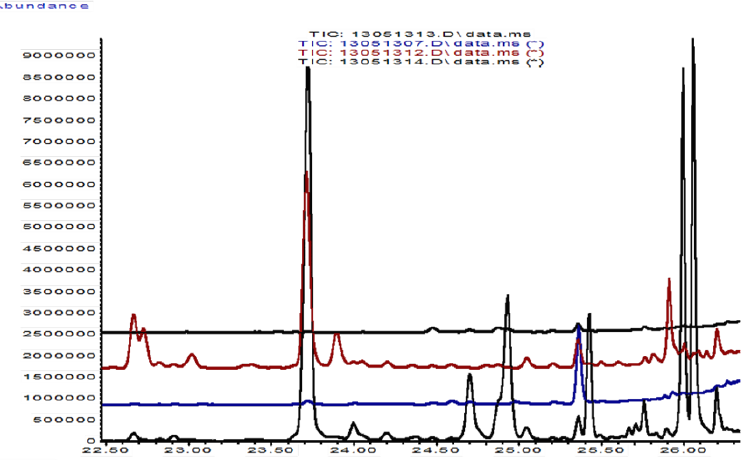
Figure 5. Volatile terpenes of K. mutabilis elicited by pH 2 solutions of HCl (below); oxalate; methyloxalate; and the neutral water control (from below to above; compare Table 3, column 7). Main compounds, below (HCl, black): 23.725 (min), alpha-longipinene; 24.000, beta-cubebene; 24.705, gamma-muurolene; 25.048, germacrene D; 25.427, (+)-sativene; 25.996, trans-alpha-bisabolene; 26.059, beta-bisabolene; 26.200, delta-cadinene. Third lowest (oxalate, blue): 25.365, (+-)-gymnomitrene. Second lowest (methyloxalate, red): 25.051, germacrene D; 25.361, (+-)-gymnomitrene; 25.912, gamma-curcumene; 26.203, delta-cadinene. Above (water control): 24.478, junipene; 24.873, gamma-muurolene; 25.355, (+-)-gymnomitrene.